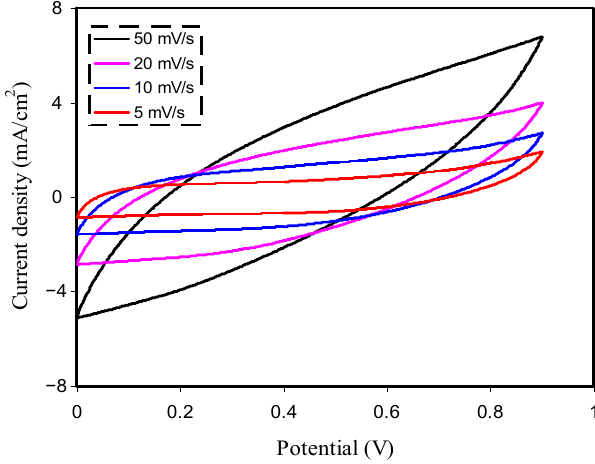
Figure 5. Cyclic voltammetry (CV) plot of the fabricated EDLC for PVCSG3 film in the potential range of 0–0.9 V.